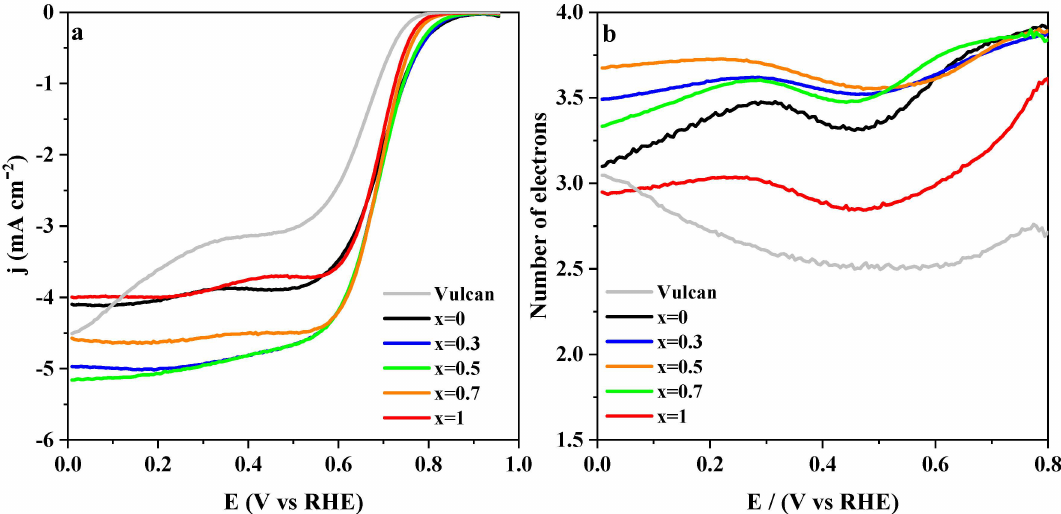
Figure 6. ( a ) RDE linear sweep voltammograms for LaMn 1 − x Co x O 3 perovskite / Vulcan XC-72R (1:1 mass ratio) in 0.1 M KOH saturated with O 2 at 1600 rpm; ( b ) Number of electrons involved in ORR at increasing potential as obtained from Equation (2) using the current measured at the